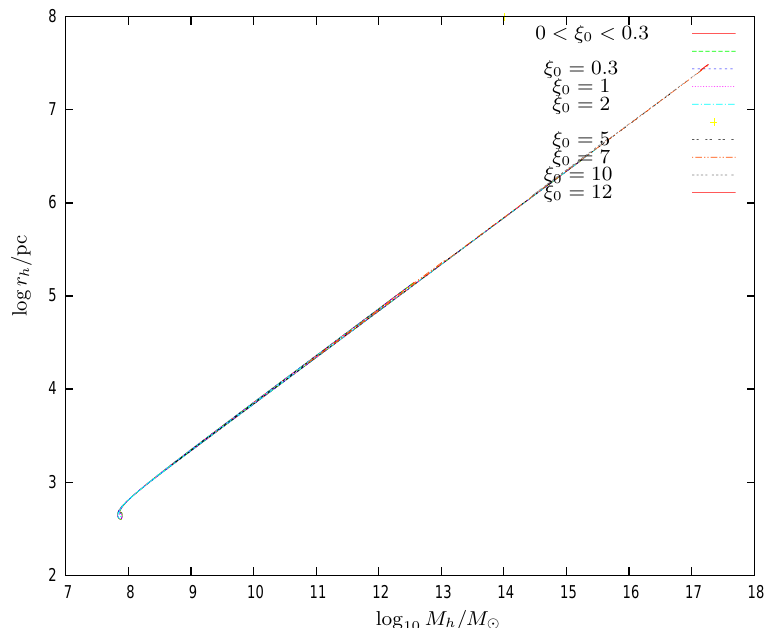
FIG. 10: The halo radius log r h vs. the common logarithm of the halo mass log M h for galaxies with supermassive central black holes of many different masses. r h turns to be a two-valued function of M h . We see that M h accurately scales as r 2 h . The same scaling was found in the Thomas-Fermi approach for galaxies in the absence of black holes [9, 10, 12].